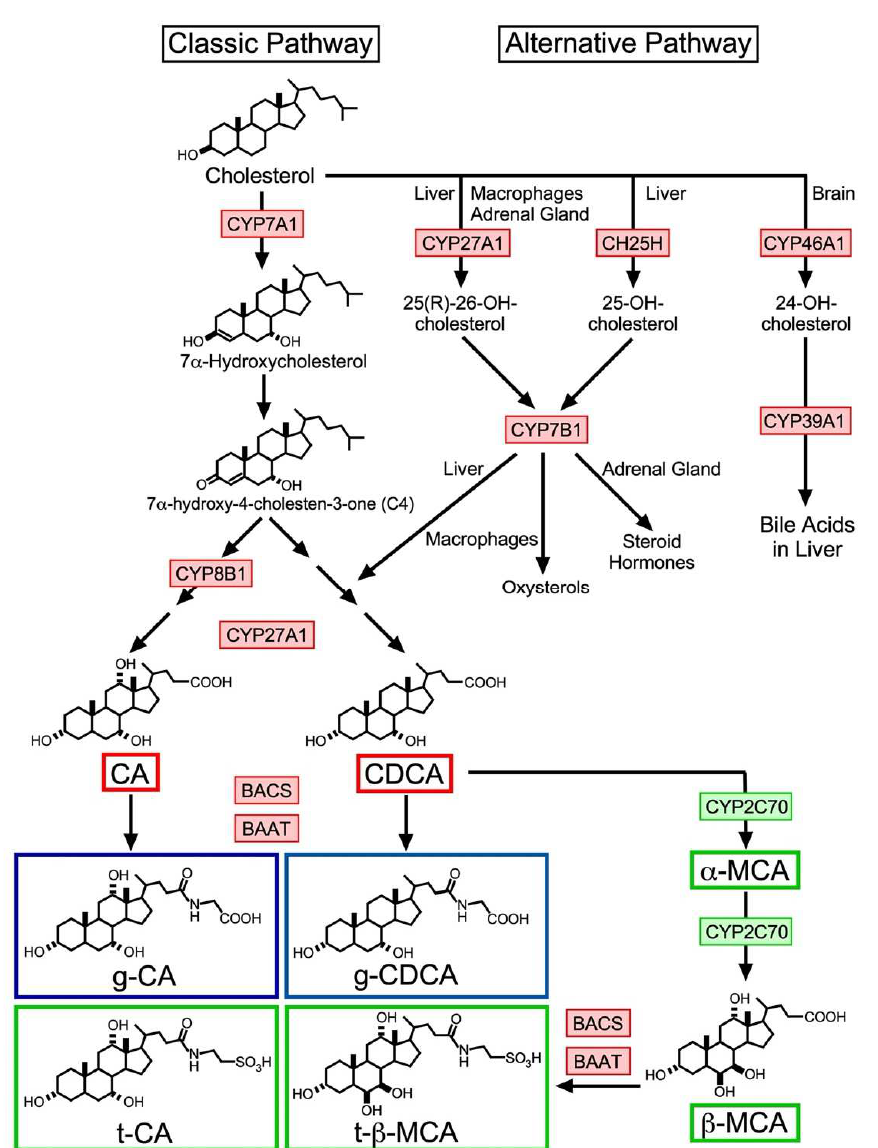
Figure 1. BA biosynthesis pathways in humans and mice. The classic bile acid biosynthesis pathway begins with converting cholesterol to 7 α -hydroxycholesterol by CYP7A1 and subsequent conversion to C4. C4 is then converted to CA or CDCA by multiple enzymes including CYP8B1 and CYP27A1. CA and CDCA are then conjugated with taurine (t-) or glycine (g-) by BACS and BAAT. In mice, CDCA is further converted to α -MCA, then β -MCA by CYP2C70, which is not present in humans. Alternative pathways are initiated by CYP27A1 in the liver, macrophages, and the adrenal gland, cholesterol 25-hydroxylase (CH25H) in the liver and CYP46A1 in the brain. Products of the first two pathways are further converted by CYP7B1 to different steroidal compounds to produce BAs, oxysterols, and steroid hormones. The last pathway is involved in regulating cholesterol levels in the brain and the final product by CYP39A1 is delivered to the liver for BA synthesis. Red boxes indicate enzymes and BAs in both humans and mice, blue boxes indicate BAs mainly in humans, and